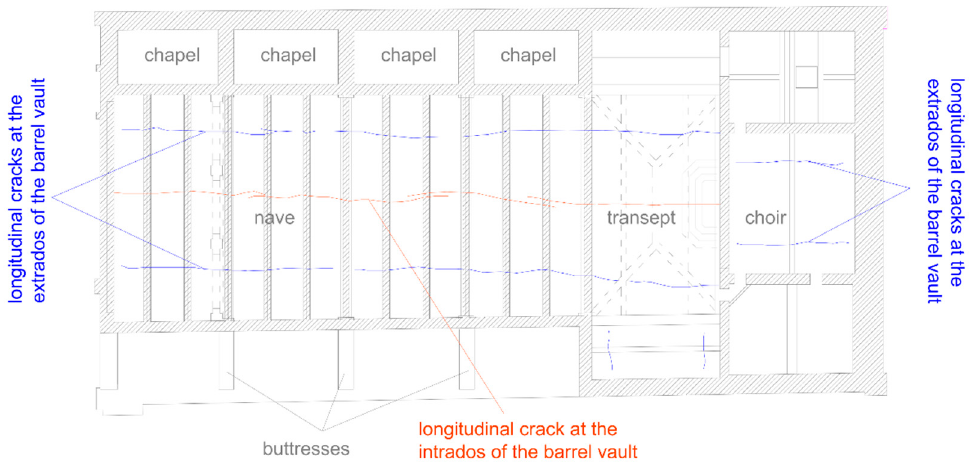
Figure 14. Crack pattern of the longitudinal barrel vault of the nave.